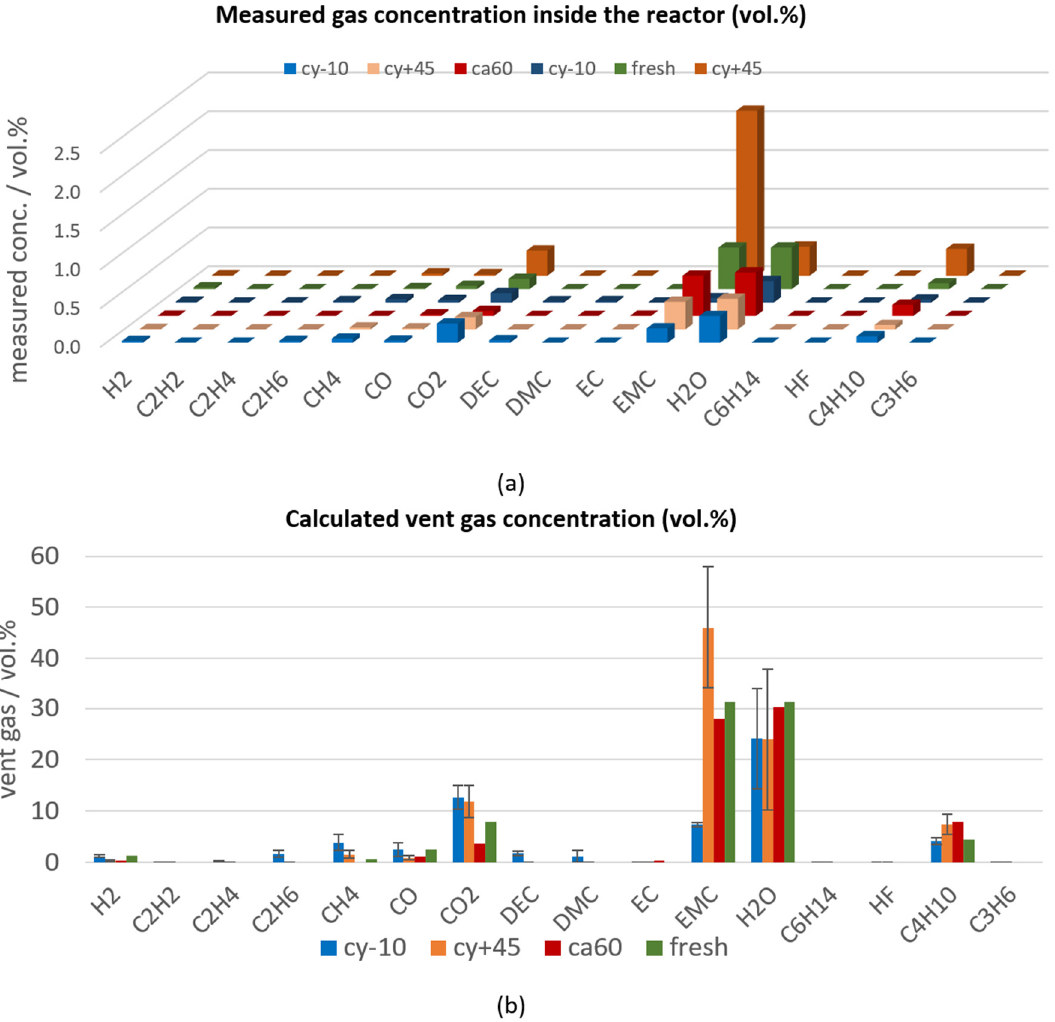
Figure 5. Vent gas composition after the first venting of aged type #1 cells (cy − 10: blue, cy+45: orange, ca60: red) in overtemperature experiments in comparison to the results of fresh cells (green). ( a ) Measured gas concentration (in vol.%) inside the reactor ranked according to the time between the venting and the gas measurement; ( b ) calculated vent gas composition in vol.% (presenting the battery vent gases only).